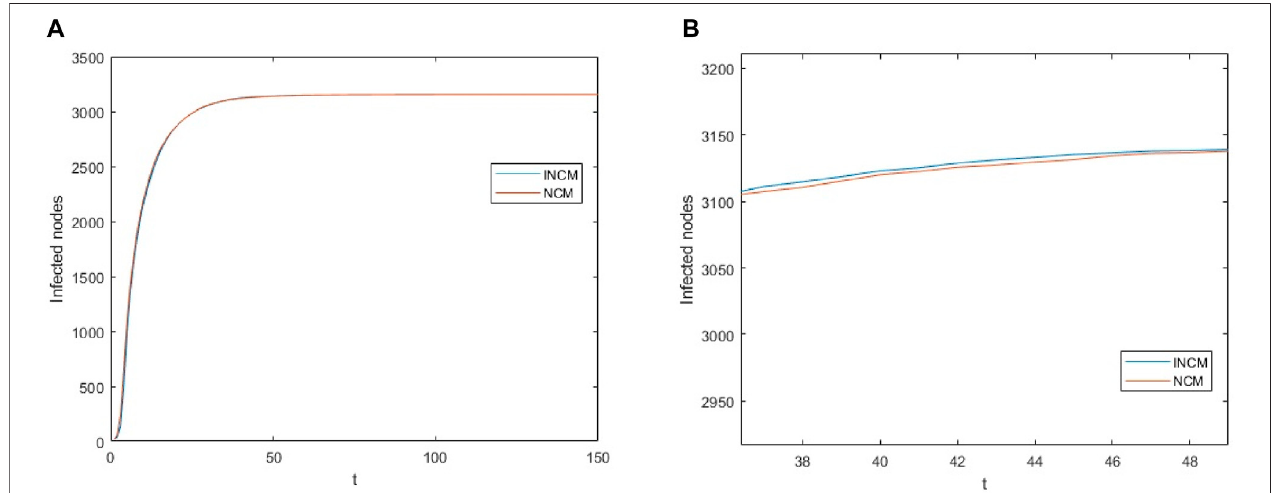
TABLE 2 | Ranking of airport importance (top 20). Ranking Closeness